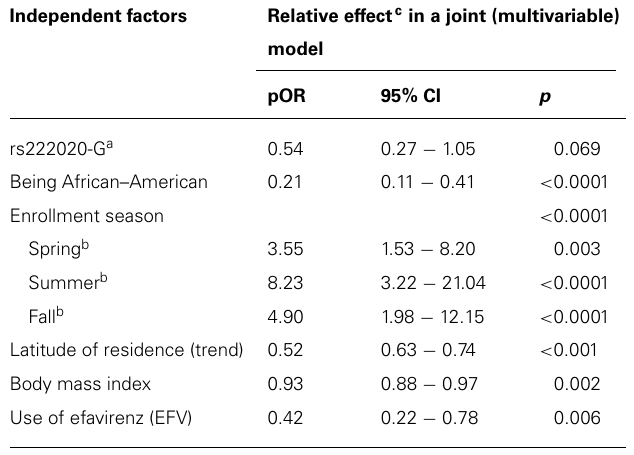
under-estimated because of partial